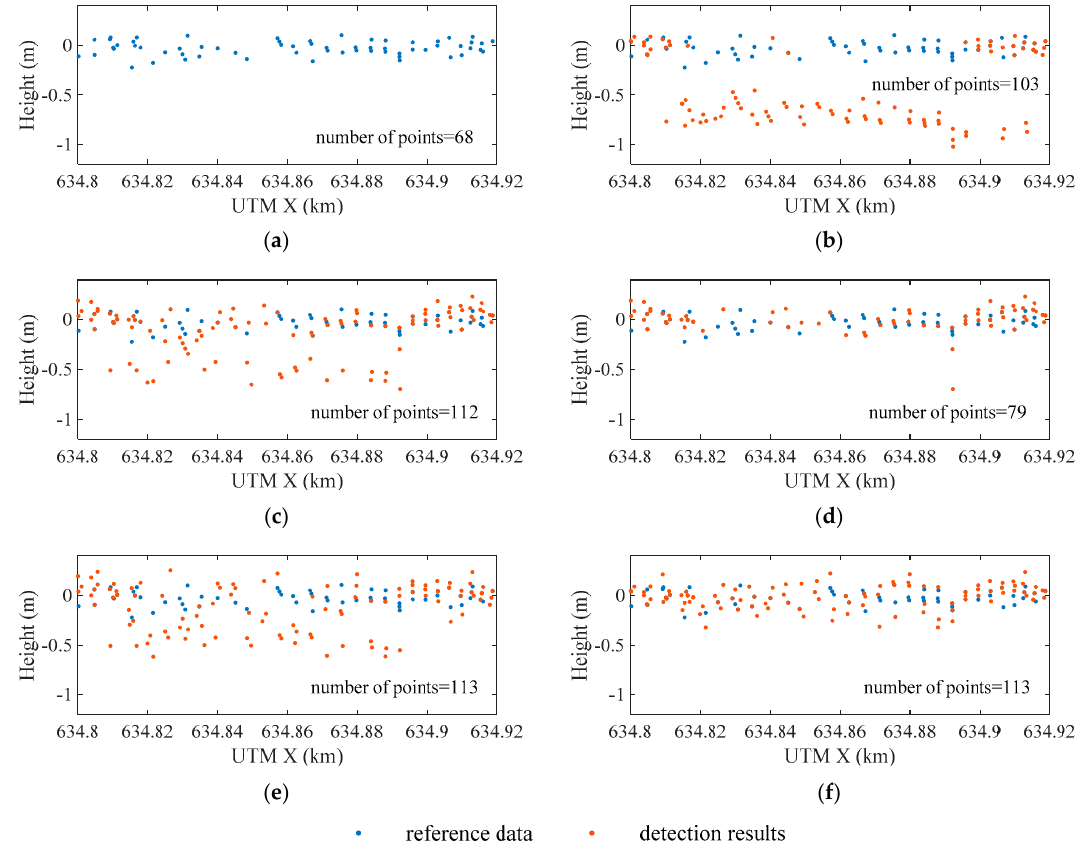
Figure 15. Comparison between the height of the water surface in reference data and detection results.